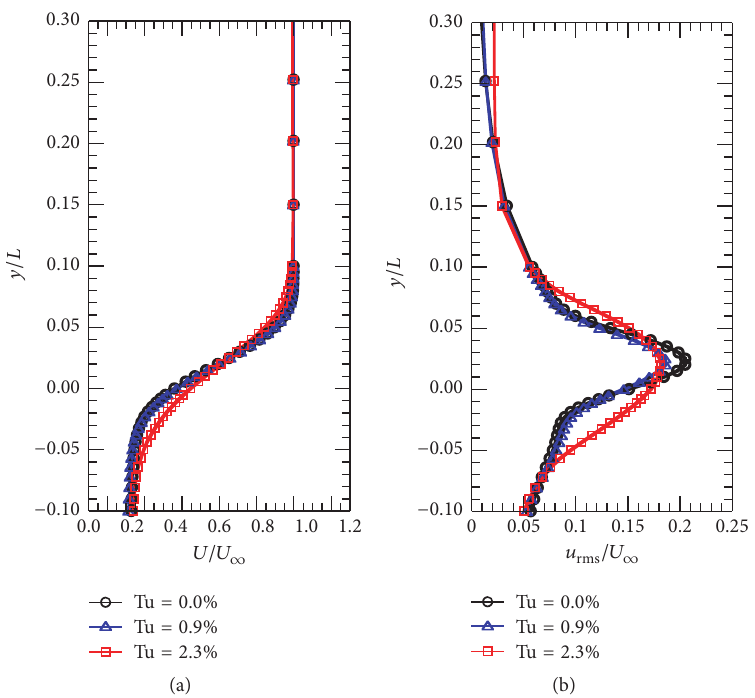
Figure 14: Predicted profiles of mean velocity (a) and turbulent intensity (b) for the cavity flow with 𝐷/𝐿 = 2.5